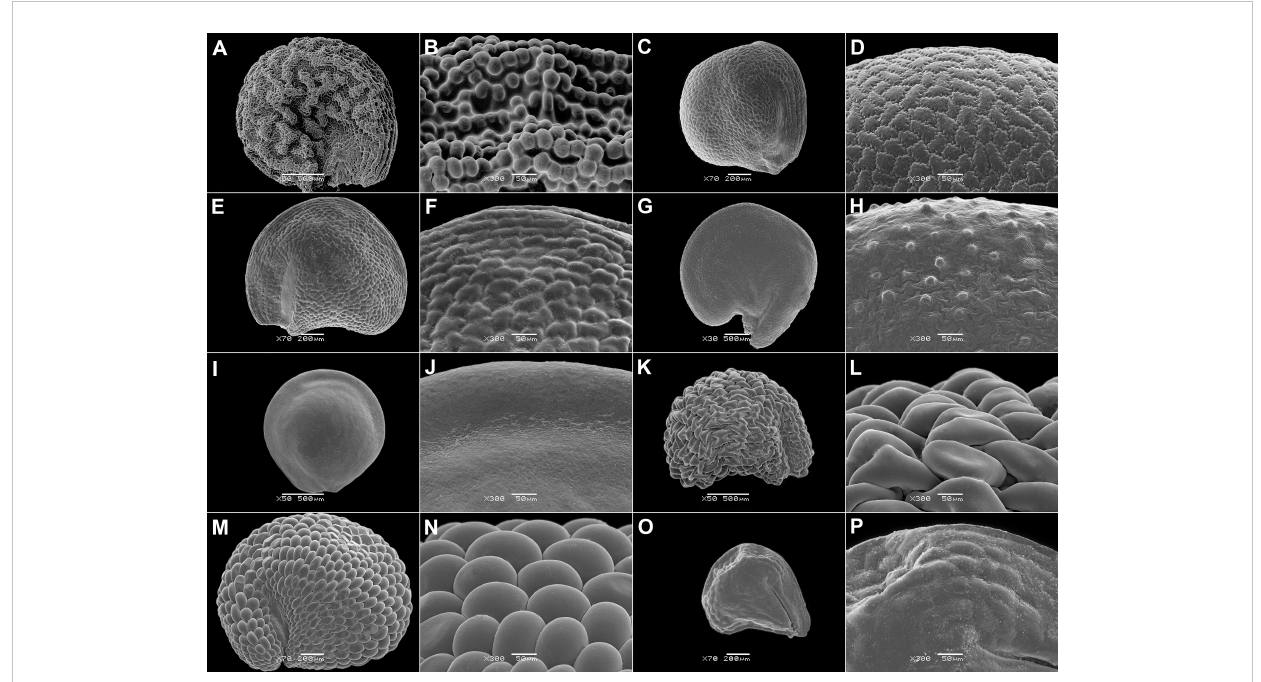
FIGURE 3 SEM micrographs of seeds of selected Acrosanthoideae and Ruschioideae (Apatesieae, Dorotheantheae) species. (A, B) Acrosanthes anceps , (C, D) Apatesia helianthoides , (E, F) Carpanthea pomeridiana , (G, H) Hymenogyne glabra , (I, J) Conicosia elongata , (K, L) Skiatophytum tripolium , (M, N) Cleretum bruynsii , and (O, P) Cleretum bellidiforme . Magni fi cation: (A, I, K) 50×; G: 30×; (C, E, M, O) 70×; (B, D, E, H, J, I, N, P)